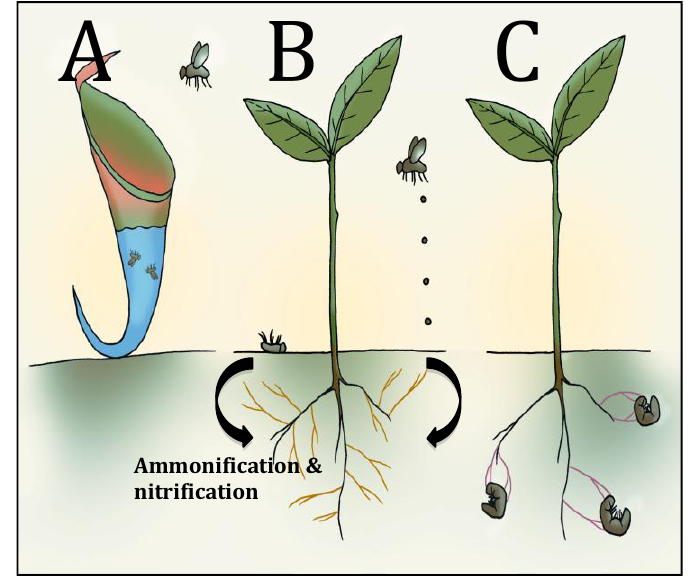
Figure 1. Representation of three major routes by which plants are able to obtain insect bound nitrogen. ( A ) Carnivorous plants capture and digest insects and acquire insect derived nitrogen. Shown is a depiction of a pitcher plant where insects are captured in a pitfall trap containing fluid and are subsequently digested. ( B ) Organic nitrogen within insects can be made available to plants from insect cadavers and from insect frass. Insect-derived nitrogen is microbially converted by ammonification and nitrification and made directly available to plants or, translocated to plants through a symbiotic association with mycorrhizal fungi (shown in yellow). ( C ) Plants are able to acquire insect derived nitrogen through a symbiotic association with EIPF. EIPF (shown as purple) infect and kill insects in the soil and insect-derived nitrogen is translocated directly to